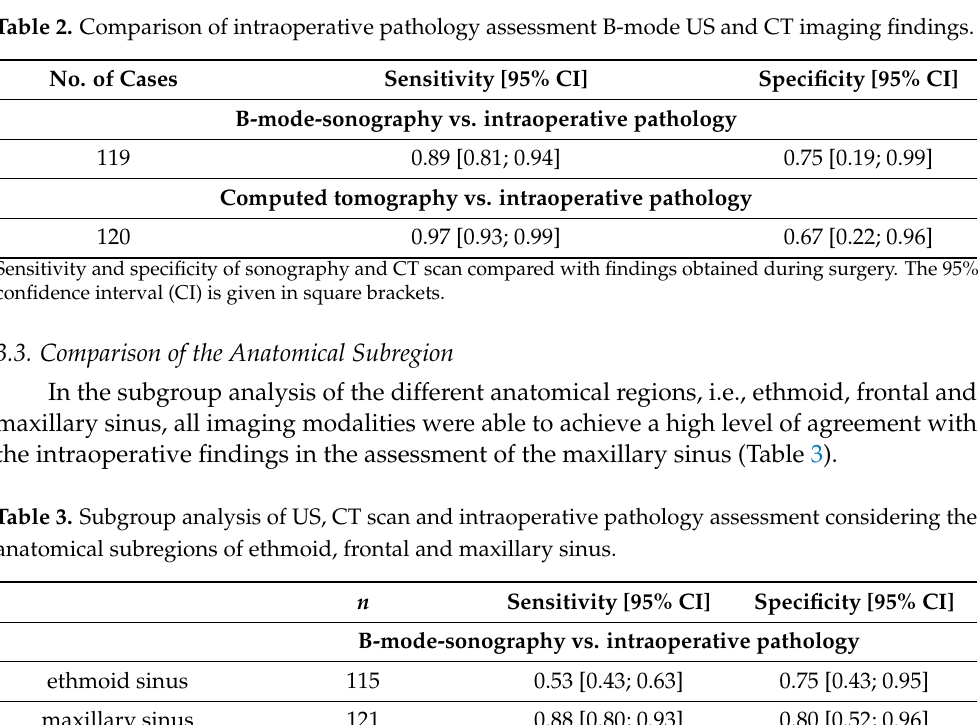
Table 3. Subgroup analysis of US, CT scan and intraoperative pathology assessment considering the anatomical subregions of ethmoid, frontal and maxillary sinus.